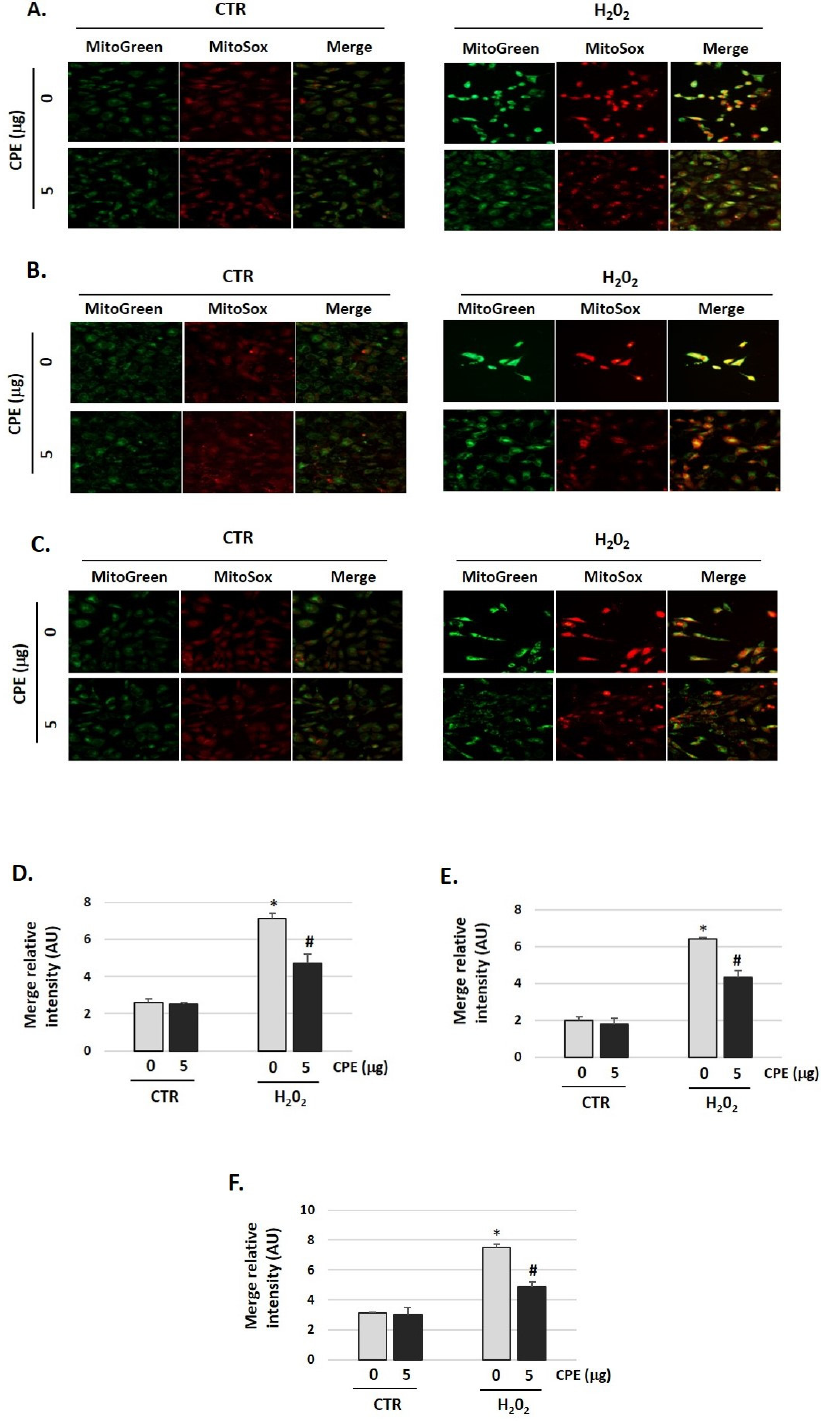
Figure 6. Cocoa reduced mitochondria-derived superoxide production in senescence cells. ( A ) Representative fluorescence images of MitoTracker Green (mitochondrial marker), MitoSOX red (mitochondrial superoxide marker), and merge (yellow) in ( A ) HEI-OC1; ( B ) OC-k3, and ( C ) SV-k1 cells. Treatments groups: CTR group (0 and 5 μ g/mL of CPE) and H 2 O 2 group (CPE-pre-treatment at 0 and 5 μ g/mL for 20 h and H 2 O 2 -post-treatment at 100 μ M for 1 h); ( D – F ) The merge fluorescence intensity per cell was calculated using ImageJ and is shown on the graphs ( D ) HEI-OC1; ( E ) OC-k3, and ( F ) SV-k1 cells. Data are means ± SD of Arbitrary Units (AU). * p < 0.05 vs of CTR group (0 μ g of CPE); # p < 0.05 vs. H 2 O 2 group (0 μ g of CPE). (n = 3).